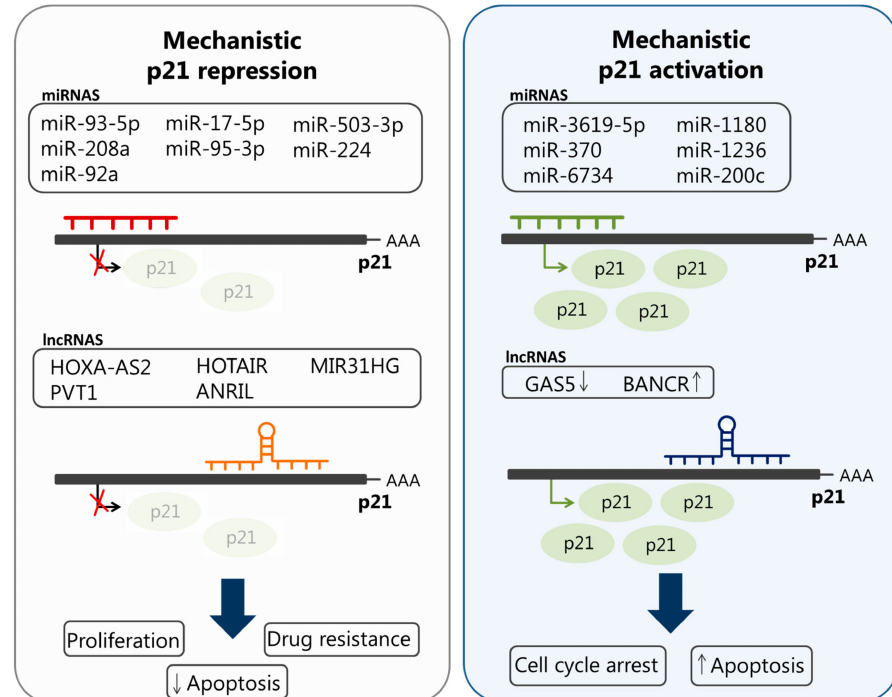
Figure 3. Regulation of p21 cip1 / waf1 expression by noncoding RNAs (ncRNAs). ( left figure